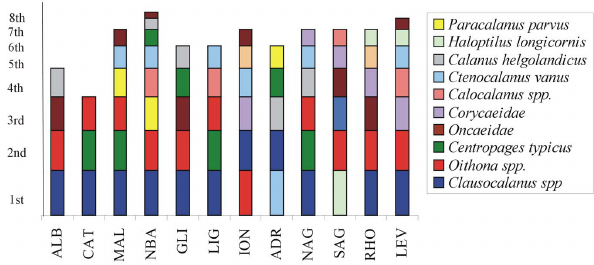
Fig. 18. Rank order of dominant copepod species or genera in the 0–200m layer of several areas of the MS in spring. The rank order of each species or genus is given in the y axis and the height of the relevant column decreases with the rank order of the species.